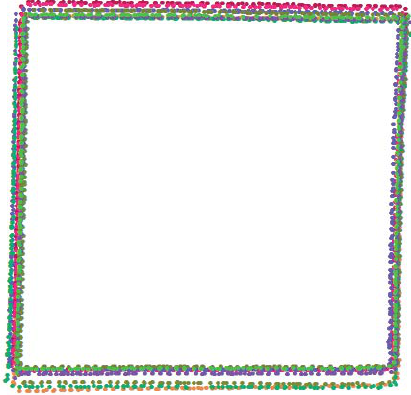
Figure 4. Graphic of ten B sections; the replicates do not